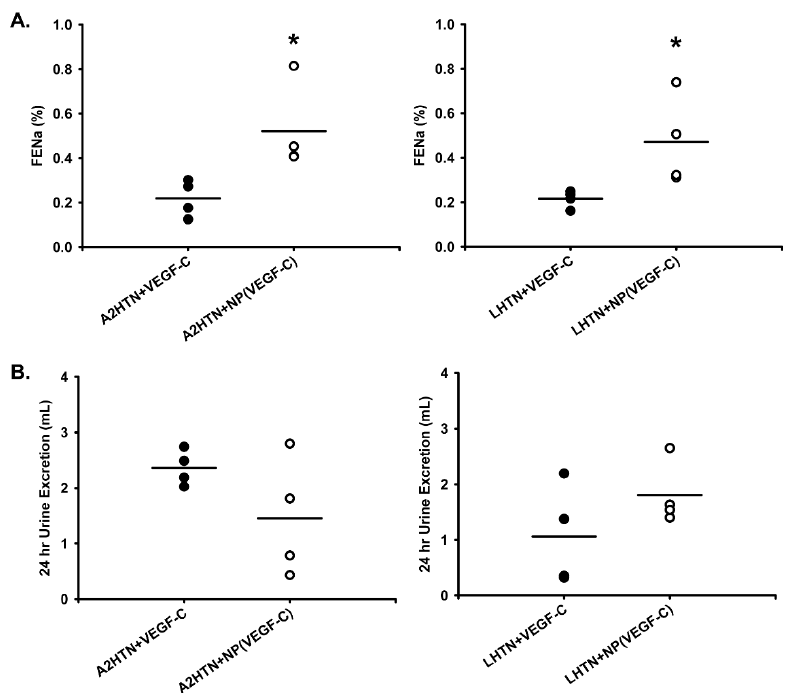
Figure 5. Treatment with VEGF-C in NPs significantly increased fractional excretion of sodium. ( A ) fractional excretion of sodium (FENa) and ( B ) 24 h urine excretion in male and female A2HTN and LHTN mice treated every 3 days with VEGF-C in NPs or VEGF-C alone. Results are expressed as mean (n = 4 per group), and statistical analyses were performed with Student’s t -test. * p < 0.05 vs. VEGF-C-alone treated mice.